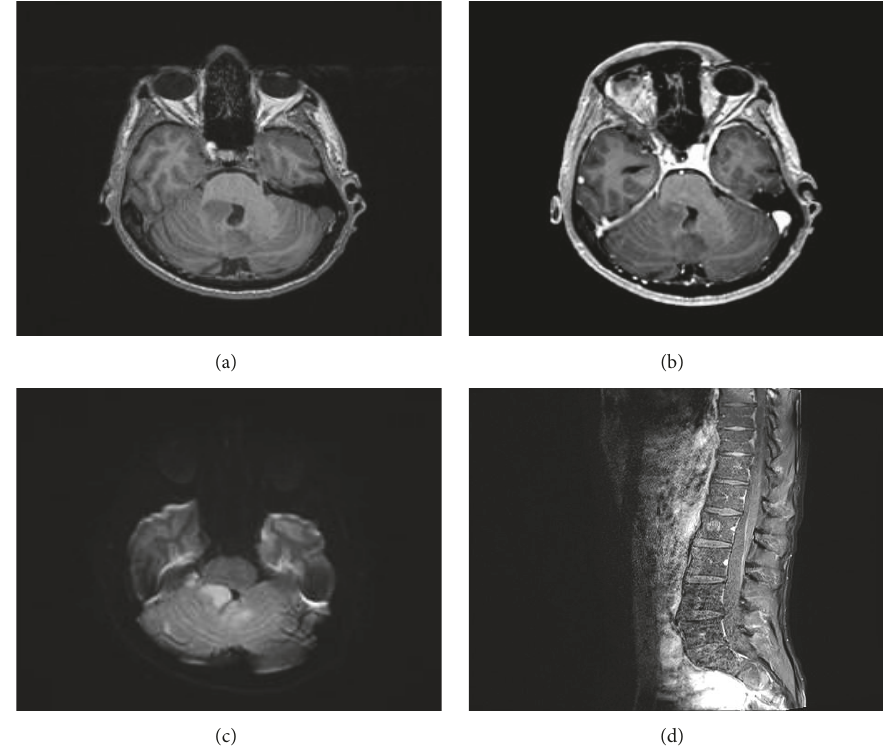
Figure 1: (a) Brain MRI T1 before contrast. (b) Brain MRI T1 after contrast. (c) FLAIR. (d) Spine MRI T1 after